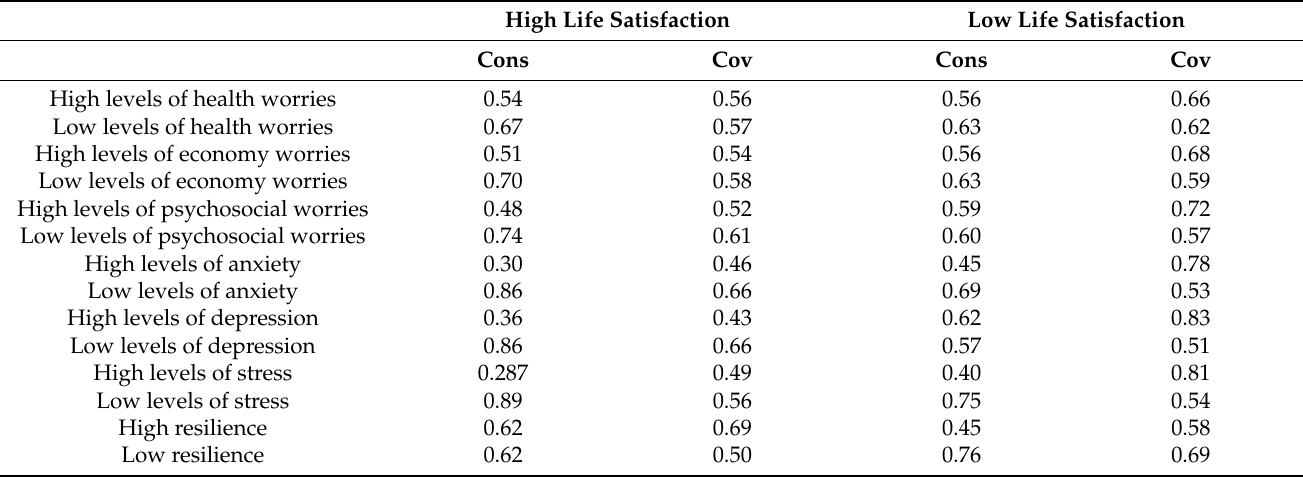
Table 3. Necessity analysis for life